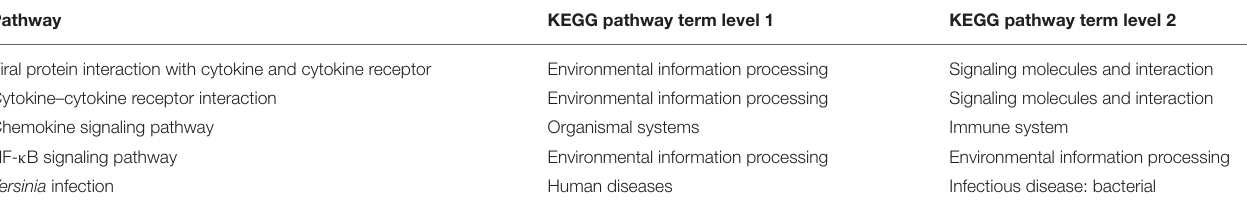
TABLE 2 | Specific pathways enriched in group TNNI2-ACTA1 V1 compared with group TNNI2 and group ACTA1.